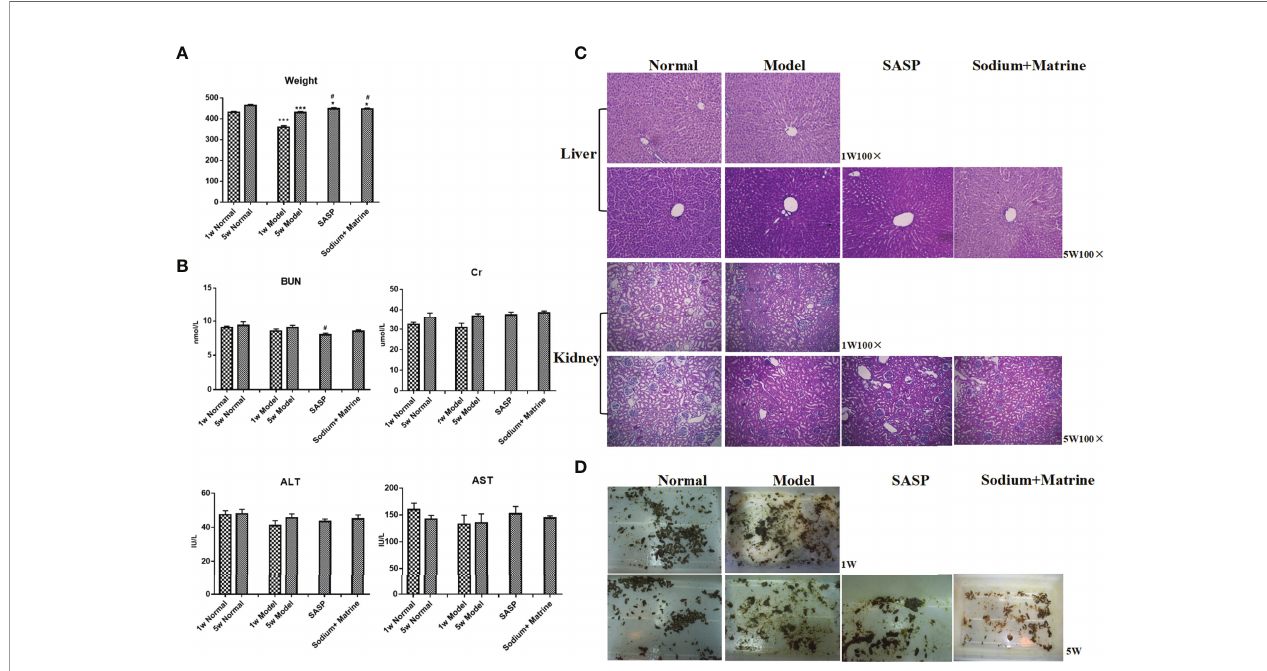
FIGURE 7 | Evaluation of toxicity of Sodium Houttuyfonate combined with Matrine in rats. Ulcerative colitis models were established with mucous membranes of colons sensitized with TNBS-alcohol enteroclysis. Treatments were administered with SASP, Sodium Houttuyfonate combined with Matrine. (A) Body weight changes. (B) Hepatorenal function changes. ALT, AST, BUN, and Cr were evaluated. (C) HE staining of liver and kidney. (D) Fecal characteristics. TNBS, immune- 2,4,6-trinitrobenzene sulfonic acid; SASP, sulfasalazine; ALT, alanine aminotransferase; AST, aspartate aminotransferase; BUN, blood urea nitrogen; Cr, Creatinine. and Compared with the model group, # P <